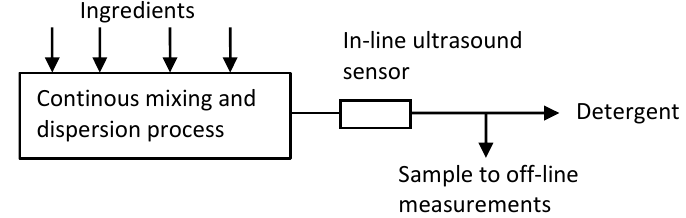
Figure 2. Experimental set-up showing the sensor and the sampling point to collect samples of liquid to bring to the off-line rheometer.